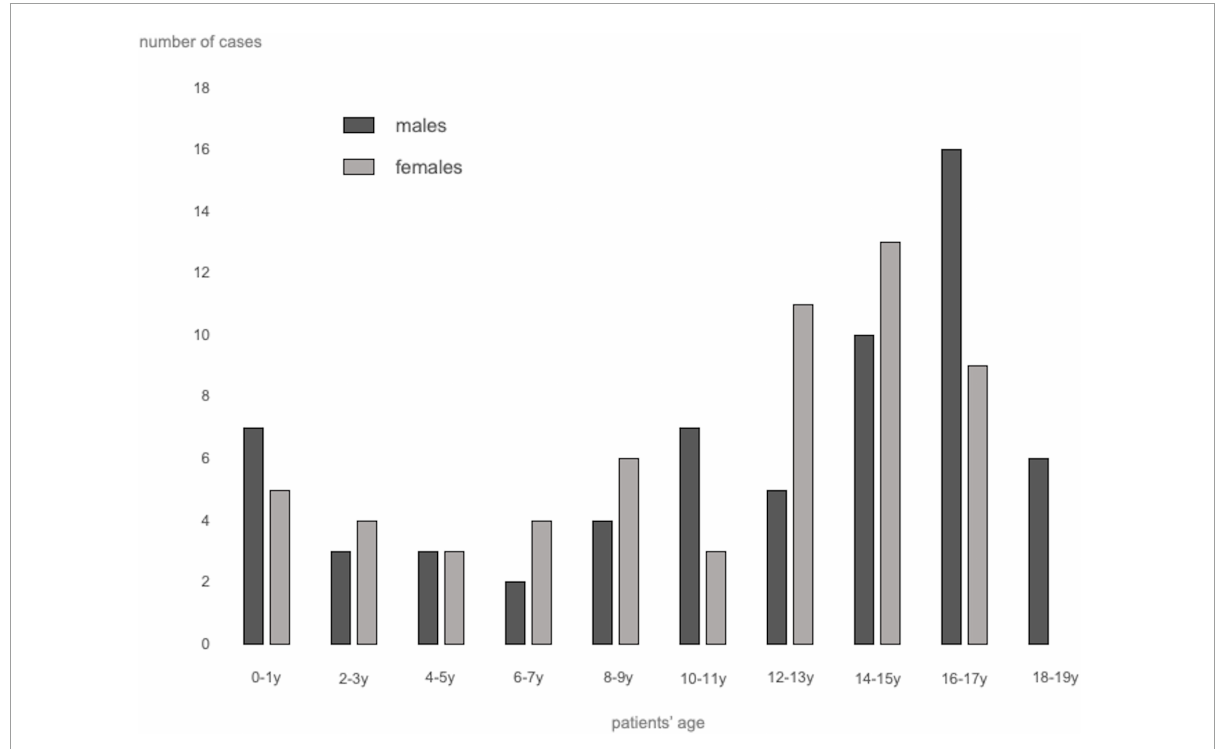
FIGURE1 Distribution of thrombotic events by age and